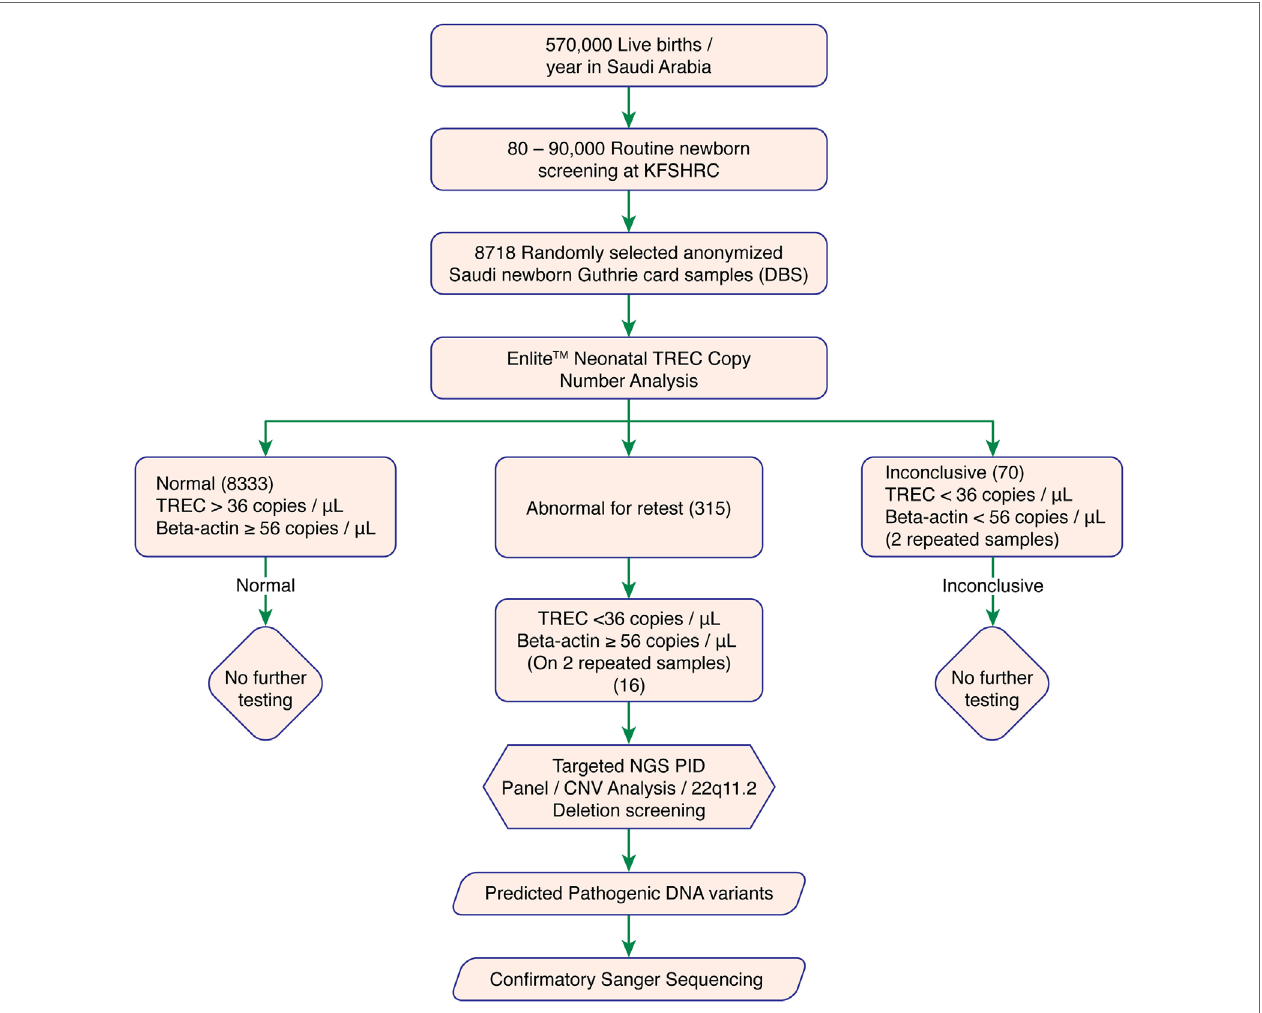
FigUre 1 | Experimental workflow. Abbreviations: KFSHRC, King Faisal Specialist Hospital & Research Center; DBS, dried blood spot; TREC, T cell receptor excision circle; NGS, Next generation sequencing; PID, primary immunodeficiency disease; qPCR, quantitative polymerase chain